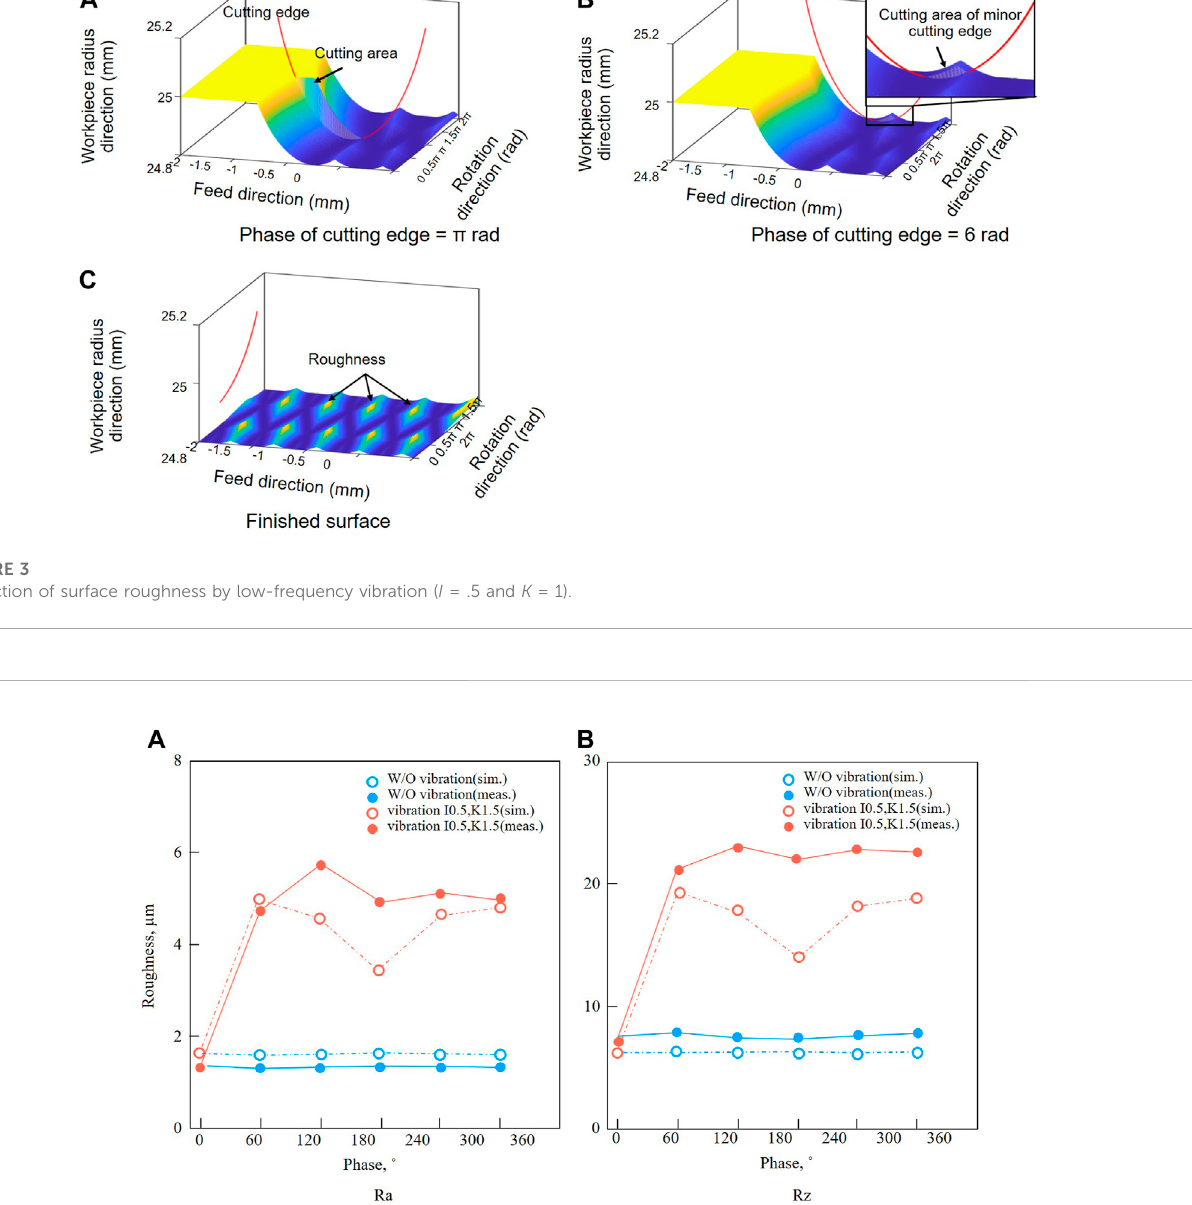
FIGURE 4 Measured surface roughness.